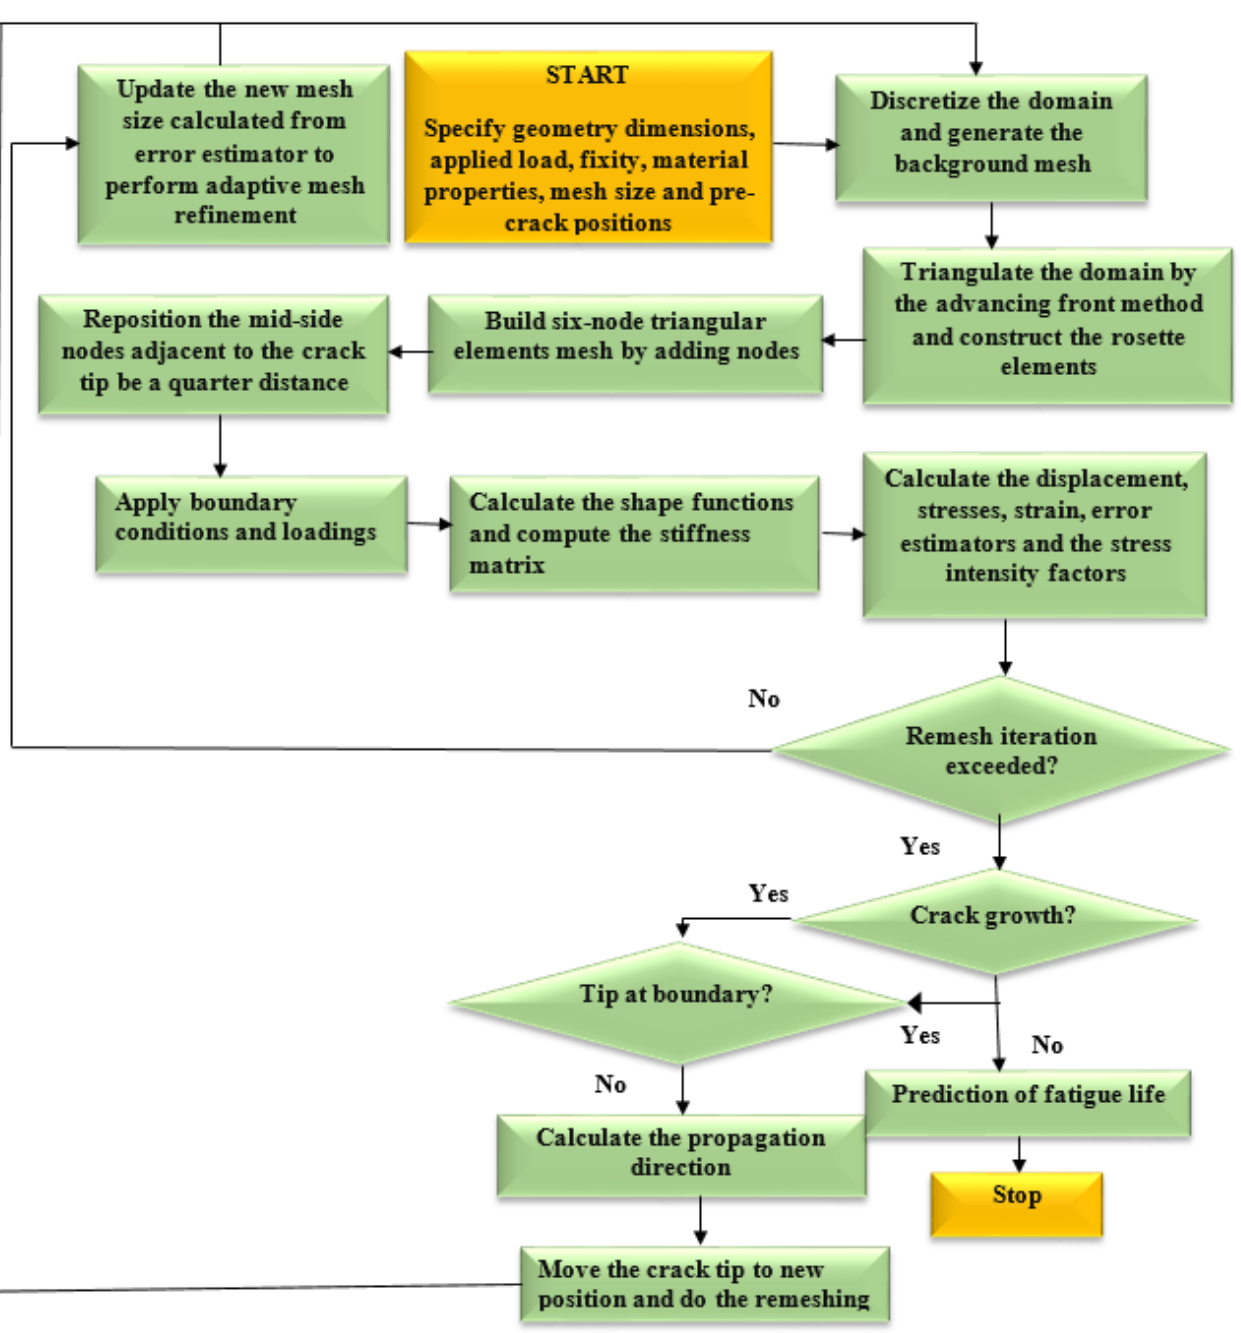
Figure 1. The program flowchart.